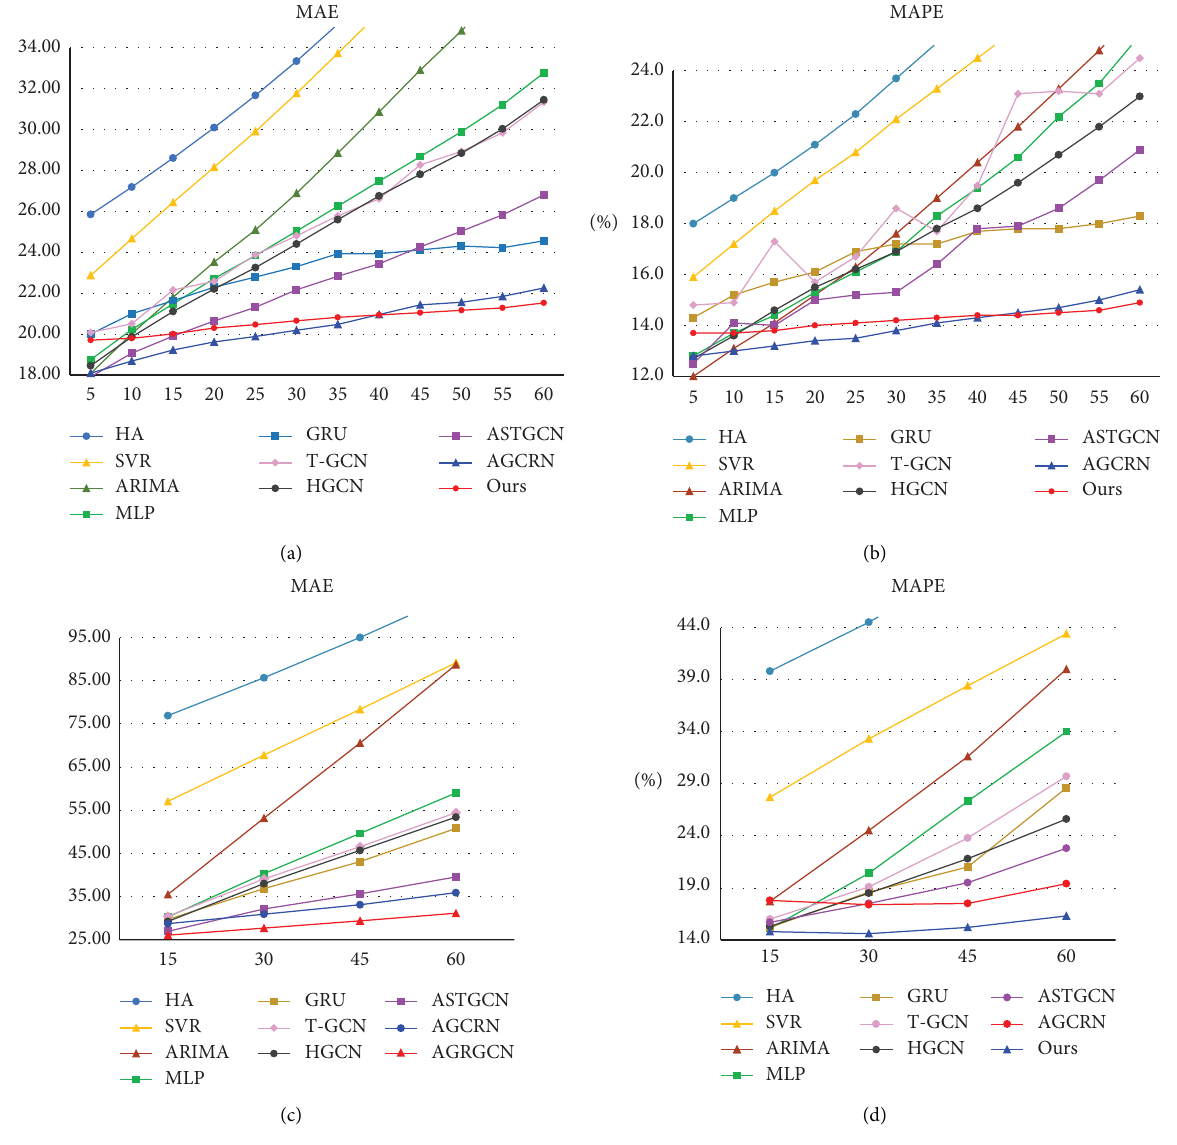
Figure 7: Prediction performance comparison at each time step on the PeMSD4 and HW-ENG